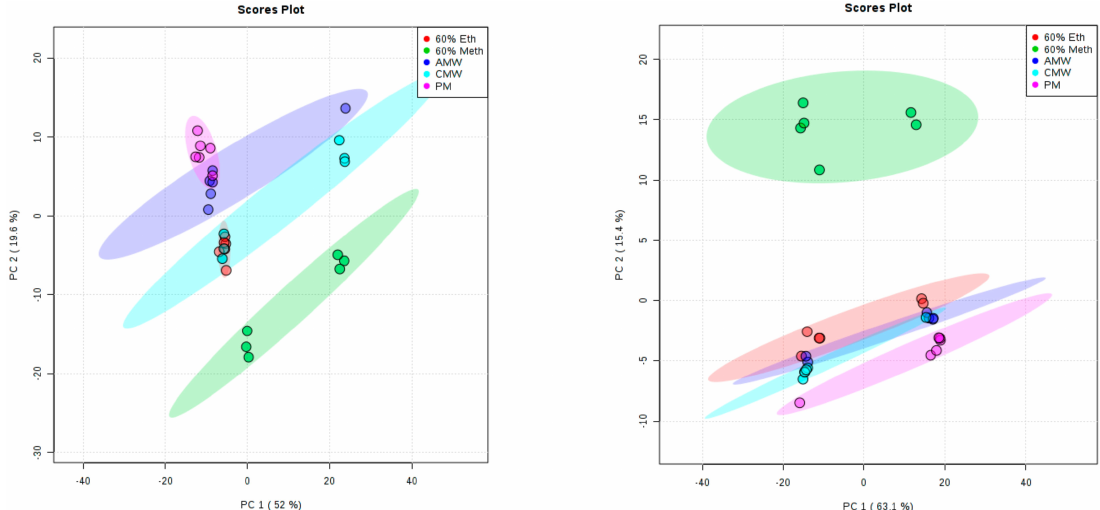
Figure 3. PCA scores plots of the polar fraction of the metabolome of ( left ) Y. enterocolitica and ( right ) Y. pseudotuberculosis (3D score plot). Different groups represent homogenates extracted using the following methods: 60% methanol, PM, 60% ETH, AMW; 2:2:1, and CMW; 2:1:1. For each extraction method, 95% confidence intervals (two standard deviations around the mean, represented by ovals) are